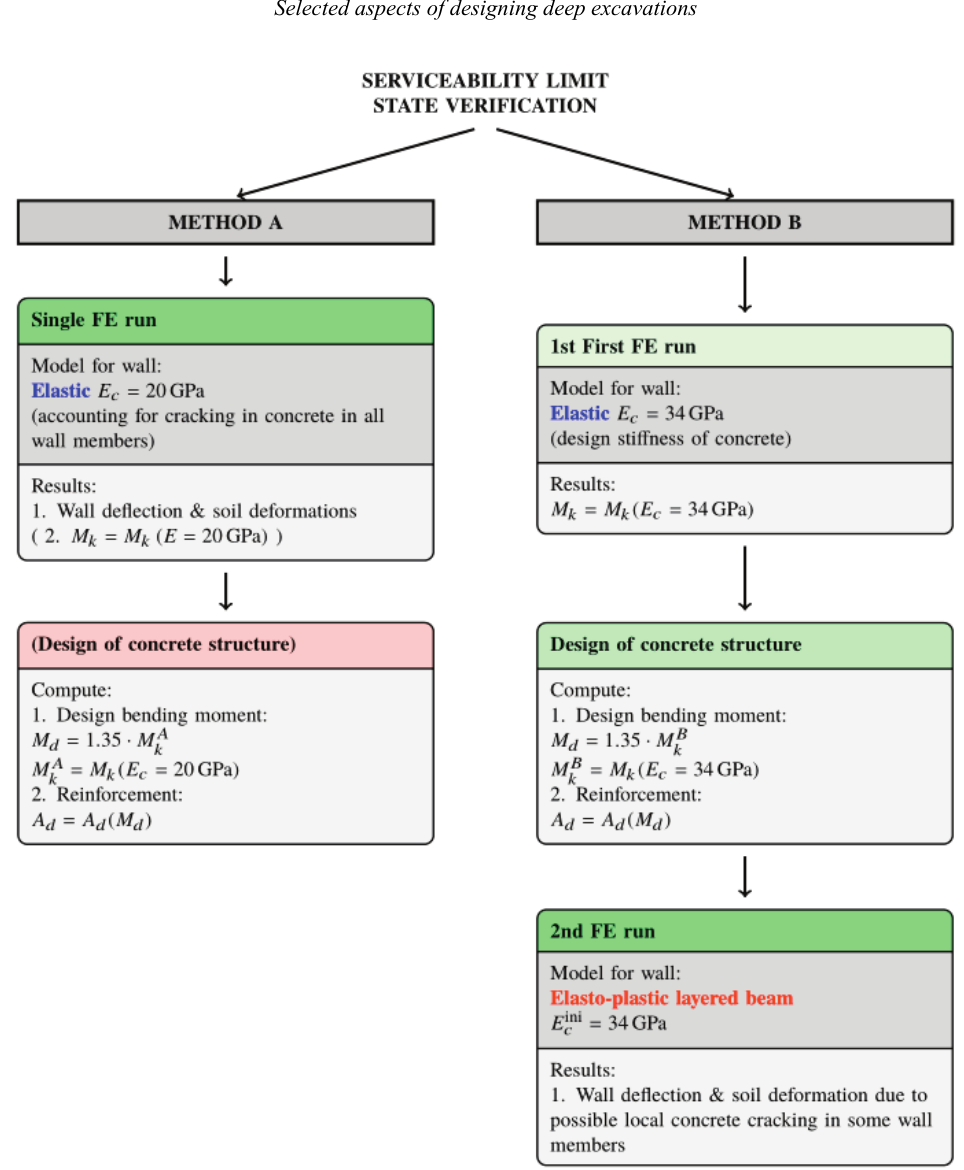
Fig. 1. Schematic workflows for two approaches for serviceability limit state